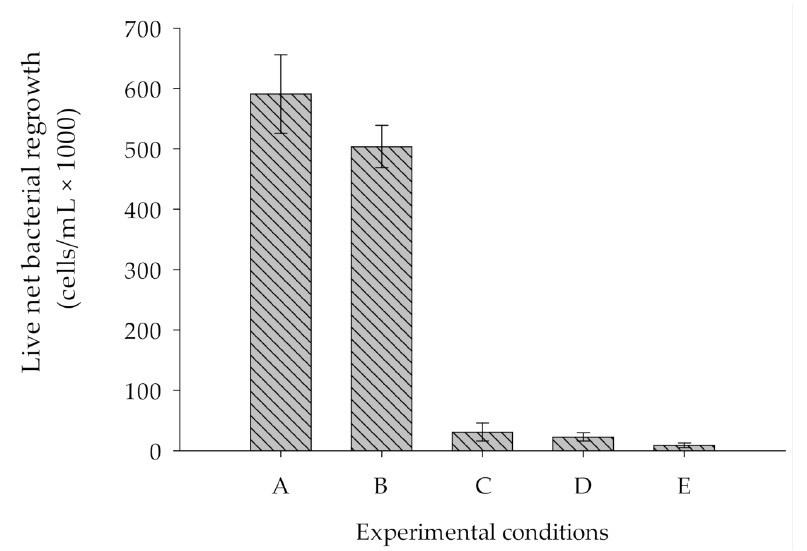
Figure 4. Comparison of live net bacterial regrowth in various ASW samples prepared with ( A ) all salts (pH = 7.8), in which both bottle and salts were not heated. ( B ) All salts (pH = 7.8), in which bottles were heated and salts were not heated. ( C ) All salts (pH = 7.8), in which both bottle and salt (NaCl only) were heated. ( D ) Two salts (NaCl + NaHCO 3 ), in which both NaCl and bottle were heated. ( E ) One salt (NaCl), in which both NaCl and bottle were